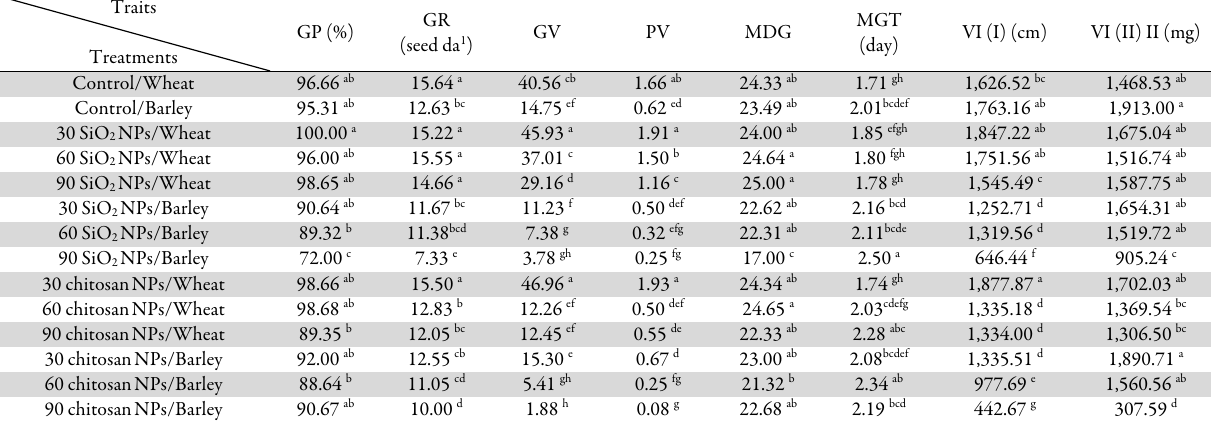
Table 5. Means comparison the influence of application SiO 2 and chitosan NPs on germination parameters of wheat and barley